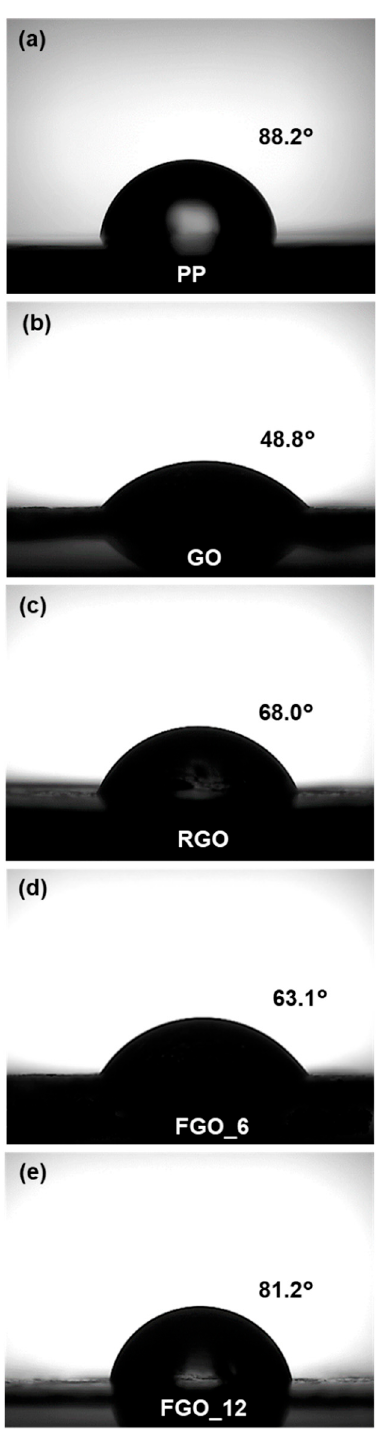
Figure 3. Optical images of probe liquid droplets on the ( a ) polypropylene (PP), ( b ) GO, ( c ) RGO, ( d ) FGO_6 and ( e ) FGO_12 film